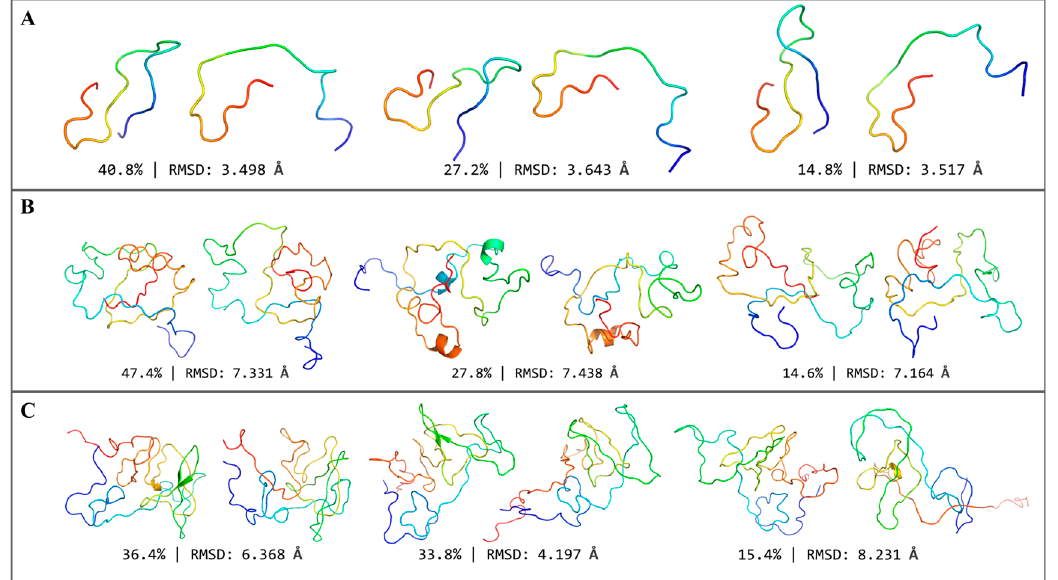
Figure 3. VAE-generated structures (right) that are centroids of the top 3 clusters compared to conformations of the minimum RMSD in MD trajectories (left), blue parts are N-terminus, and red parts are C-terminus here. ( A ) RS1. ( B ) R17. ( C ) α -synuclein.